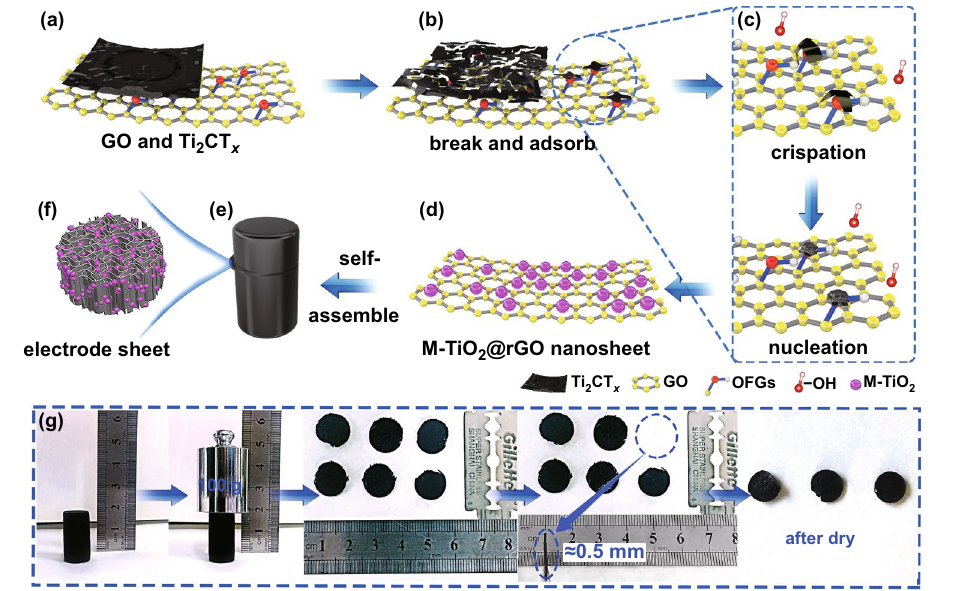
Fig. 1 The schematic and digital pictures of the M‑TiO 2 @rGO. a GO and Ti 2 CT x nanosheet; b Ti 2 CT x breaks and adsorbs on OFGs, and then c through crispation, finally, d reacts with OFGs and OH − to form MXene‑derived TiO 2 ; e M‑TiO 2 @rGO nanosheets through self‑assemble pro‑ cess come into being composite gel; f internal structure of self‑supporting electrode sheet; and g physical character of the M‑TiO 2 @rGO gel and self‑supporting